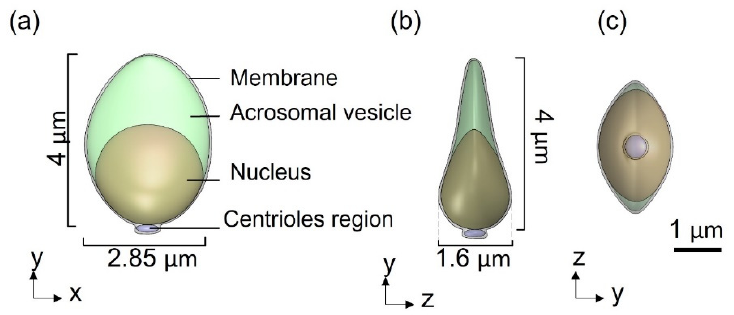
Figure 2. 3D sperm head geometrical model: ( a ) Side view of the head model, containing the acrosomal vesicle, nucleus, membrane, and centrioles region. ( b , c ) Top and rear views of the head model.